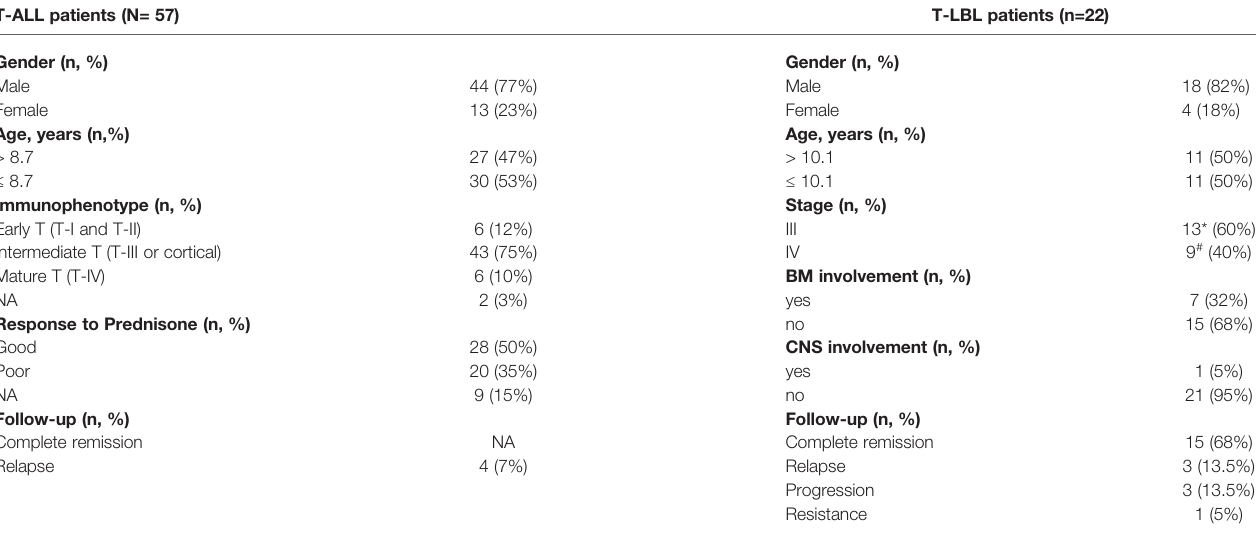
TABLE 1 | Main clinical characteristic of T-ALL and T-LBL patients included in the study. T-ALL patients (N=